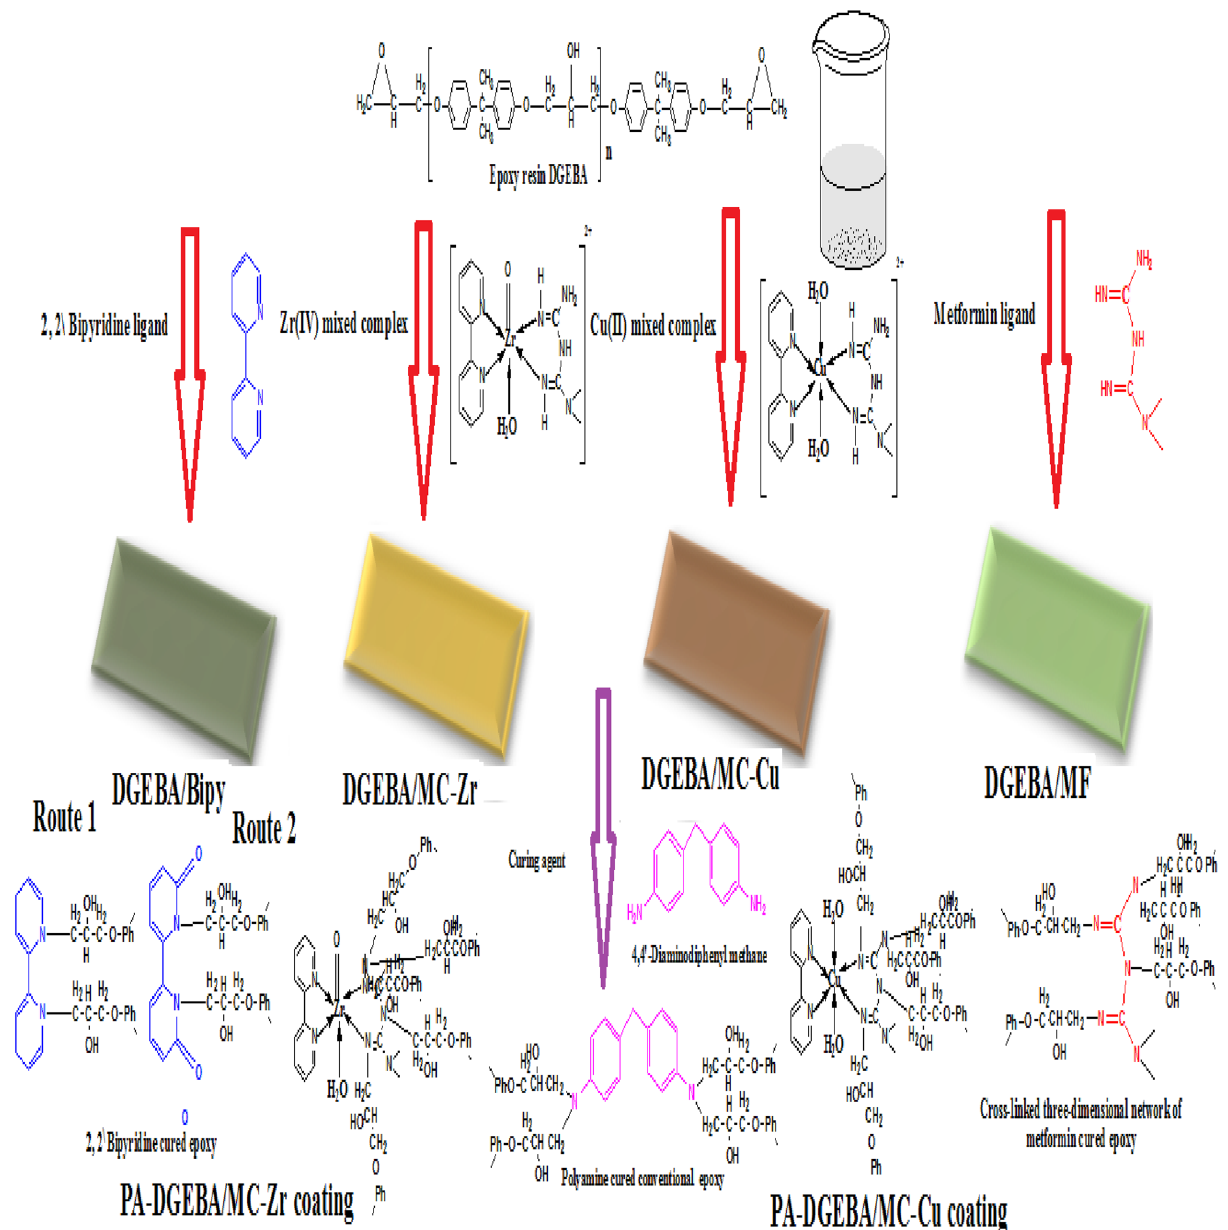
Figure 2. The suggested three-dimensional networks of cured epoxy with MF, Bipy ligands and their mixed Zr(IV), and Cu(II)